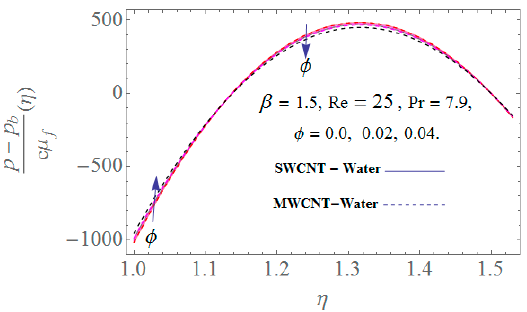
Figure 12. Impact of the nanoparticle volume fraction versus pressure distribution.